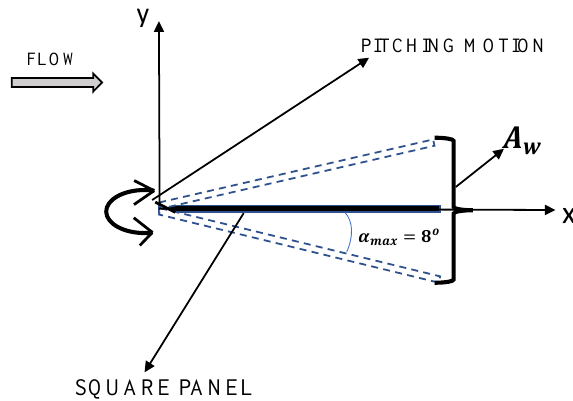
Figure 3. Parametric description of motion of pitching panel (Case